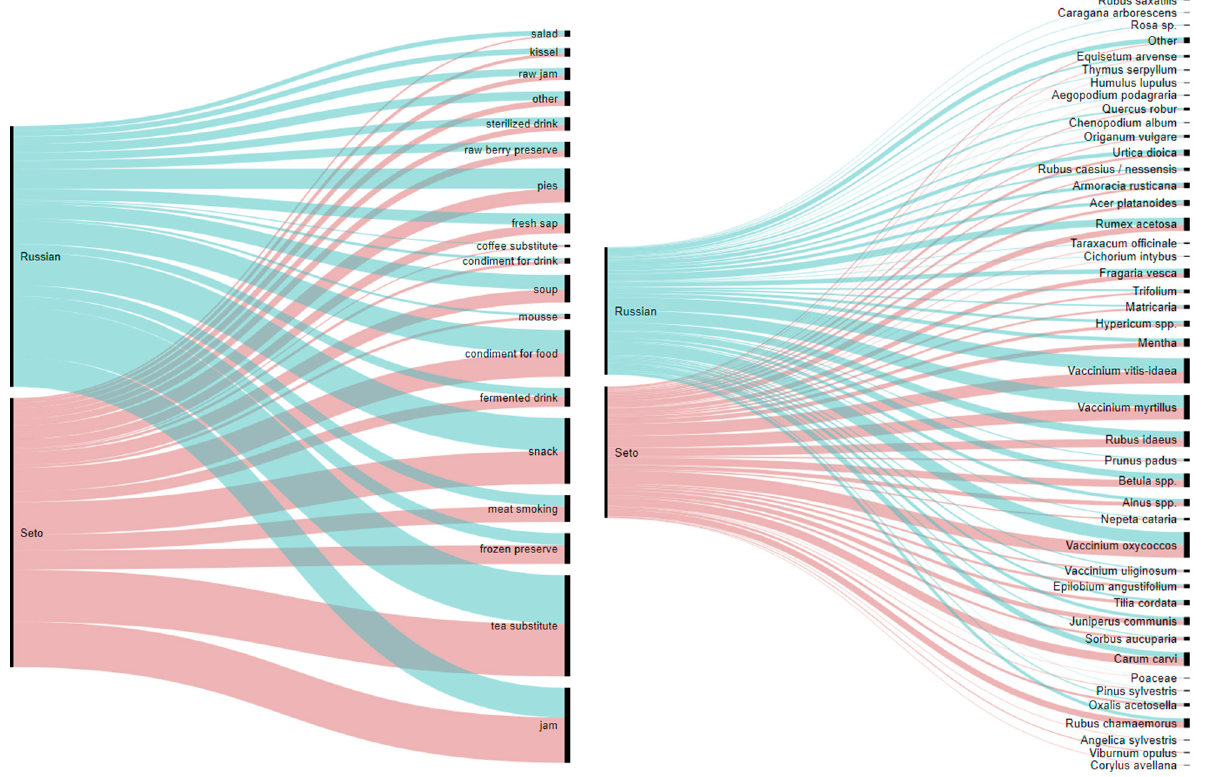
Figure 5. Cross-cultural comparison of food categories and wild plant taxa.